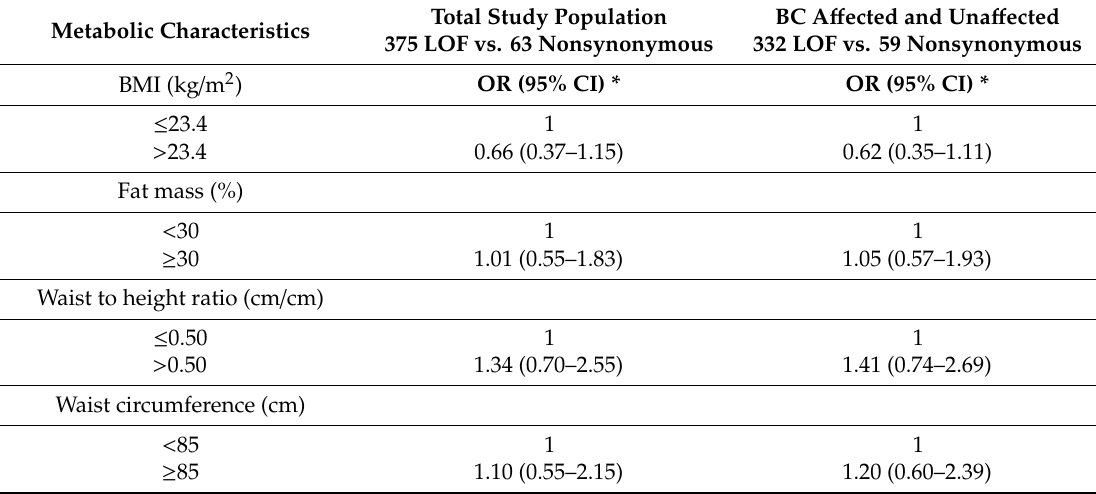
Table 4. Association between metabolic characteristics and BRCA variant